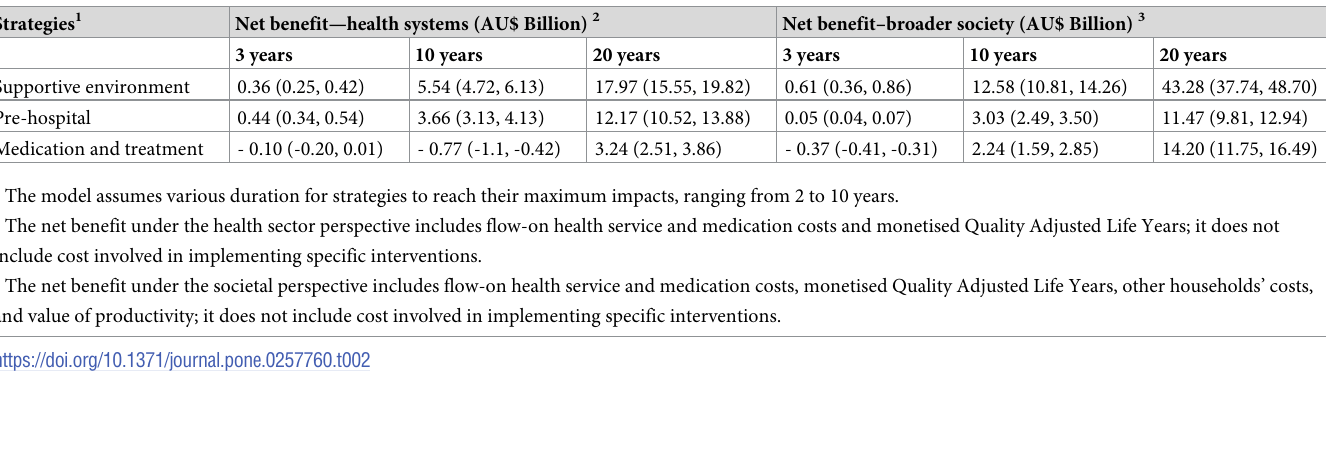
Fig 3. Relative reduction (%) in cumulative impacts on hospitalisations as a result of strategies and their interquartile ranges at 3, 10, 20 years; strategies are combined into three groups: Supportive environment, pre- hospital, and medication and treatment.